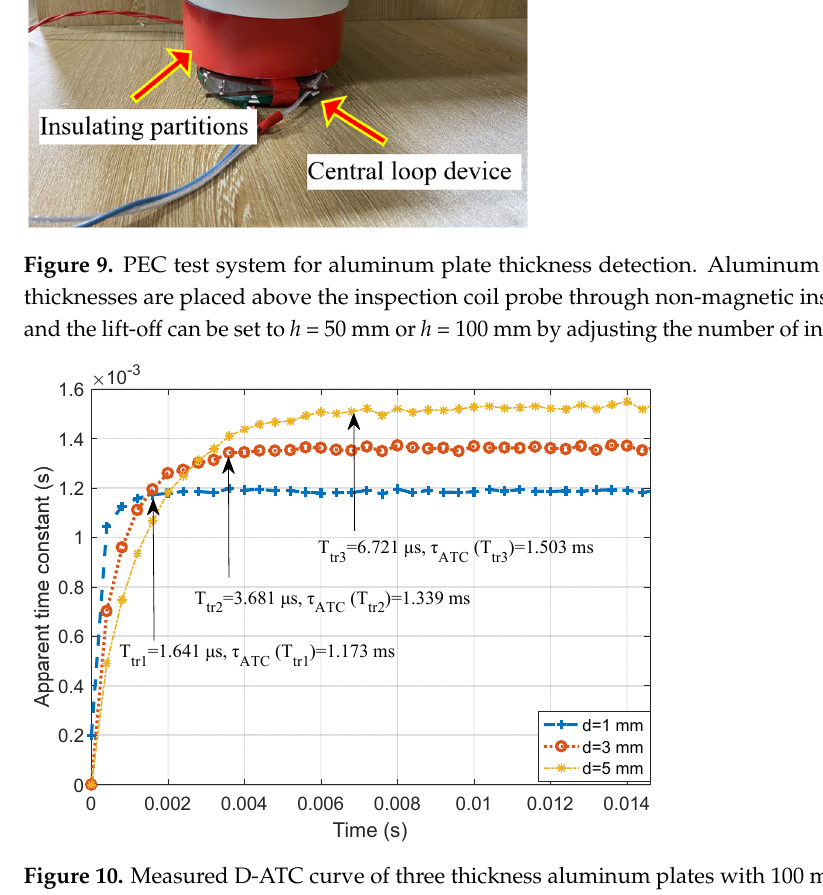
Figure 9. PEC test system for aluminum plate thickness detection. Aluminum plates of different thicknesses are placed above the inspection coil probe through non-magnetic insulating partitions, and the lift-off can be set to h = 50 mm or h = 100 mm by adjusting the number of insulating partitions. In the case of lift-off ℎ = 100 mm , the D-ATC curves of aluminum plates with thick- nesses 𝑑 = 1 mm , 3 mm, and 5 mm are shown as the blue dashed line, red dotted line, and yellow dash-dotted line in Figure 10, respectively. It can be seen that the steady-state values 𝜏 (cid:3002)(cid:3021)(cid:3004) (𝑇 (cid:3047)(cid:3045) ) of the three D-ATC curves obey the arithmetic progression, which veri- fies the linear relationship between the thickness 𝑑 and 𝜏 (cid:3002)(cid:3021)(cid:3004) (𝑇 (cid:3047)(cid:3045) ) shown in Figure 6b.